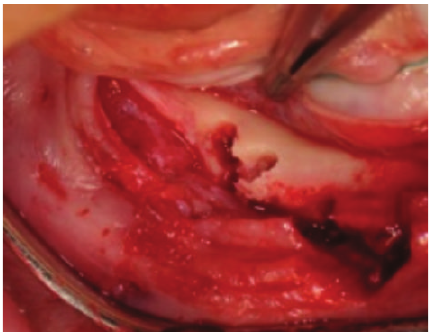
Figure 5: The surgical template in situ.